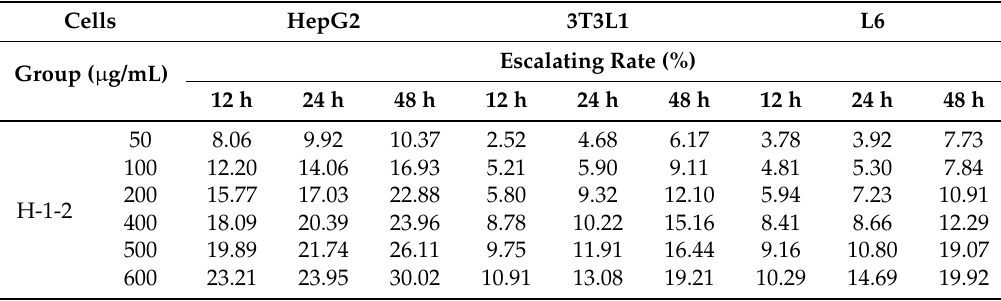
Table 3. Effects of H-1-2 on cellular glucose uptake ( n = 5).